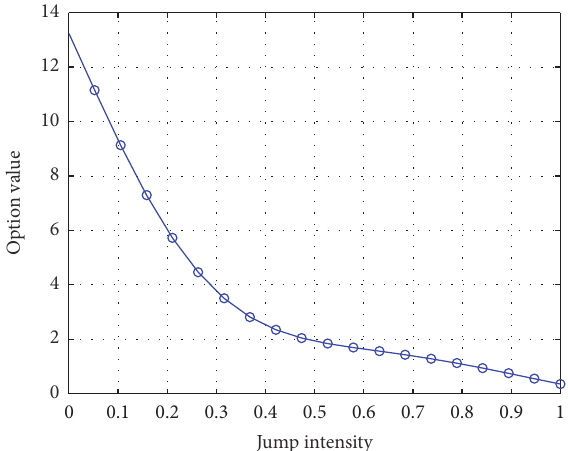
Figure 3: Option value with different jump